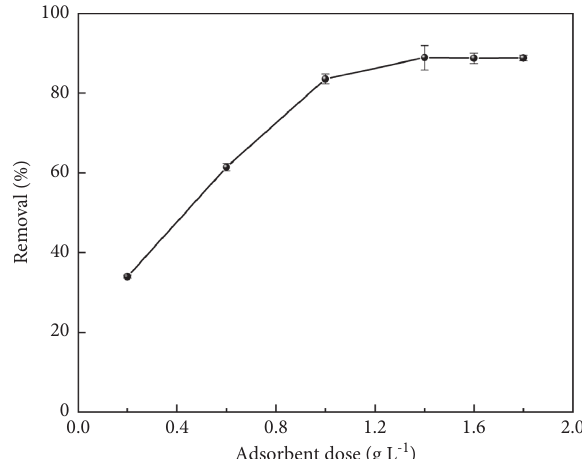
Figure 8: The effect of adsorbent dose.